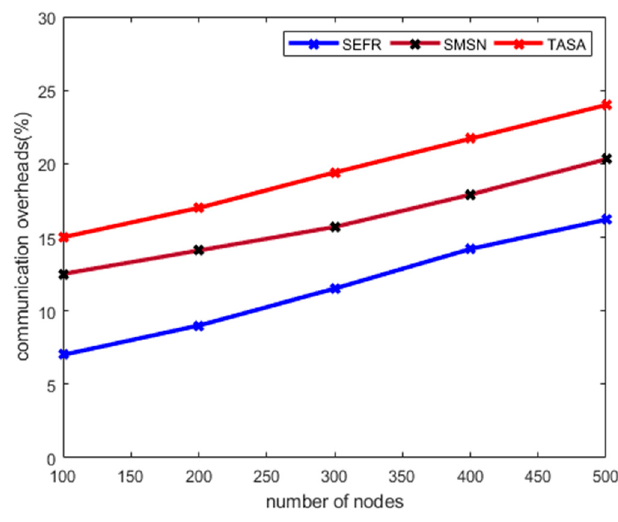
Figure 6. Communication overhead with varying number of nodes.